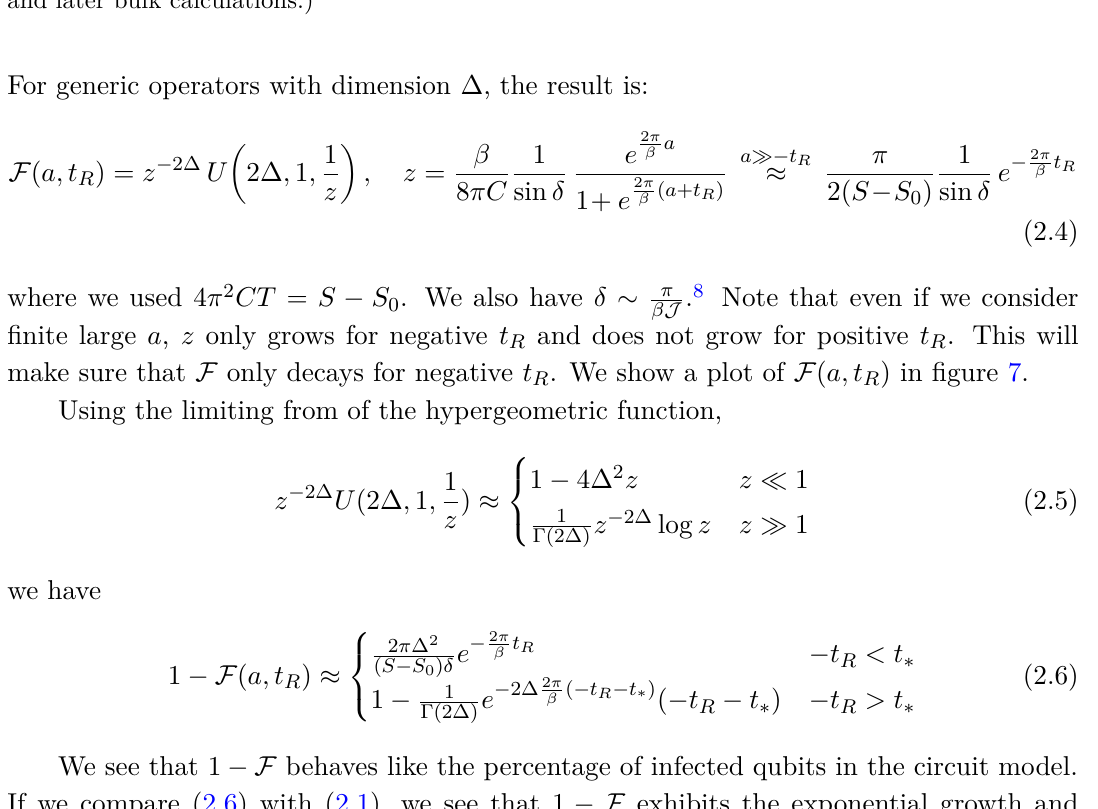
Figure 7 . Plot of the four-point function F ( a, t R ) defined in (2.2) and its leading approximation corresponding to the exchange of a single Schwarzian mode (see (A.5)). We set a = 100 , β = 2 π , ( S − S 0 ) sin δ = 10 10 , and ∆ = 1 . (Setting ∆ = 1 gives the best match with the epidemic model 2 2 and later bulk